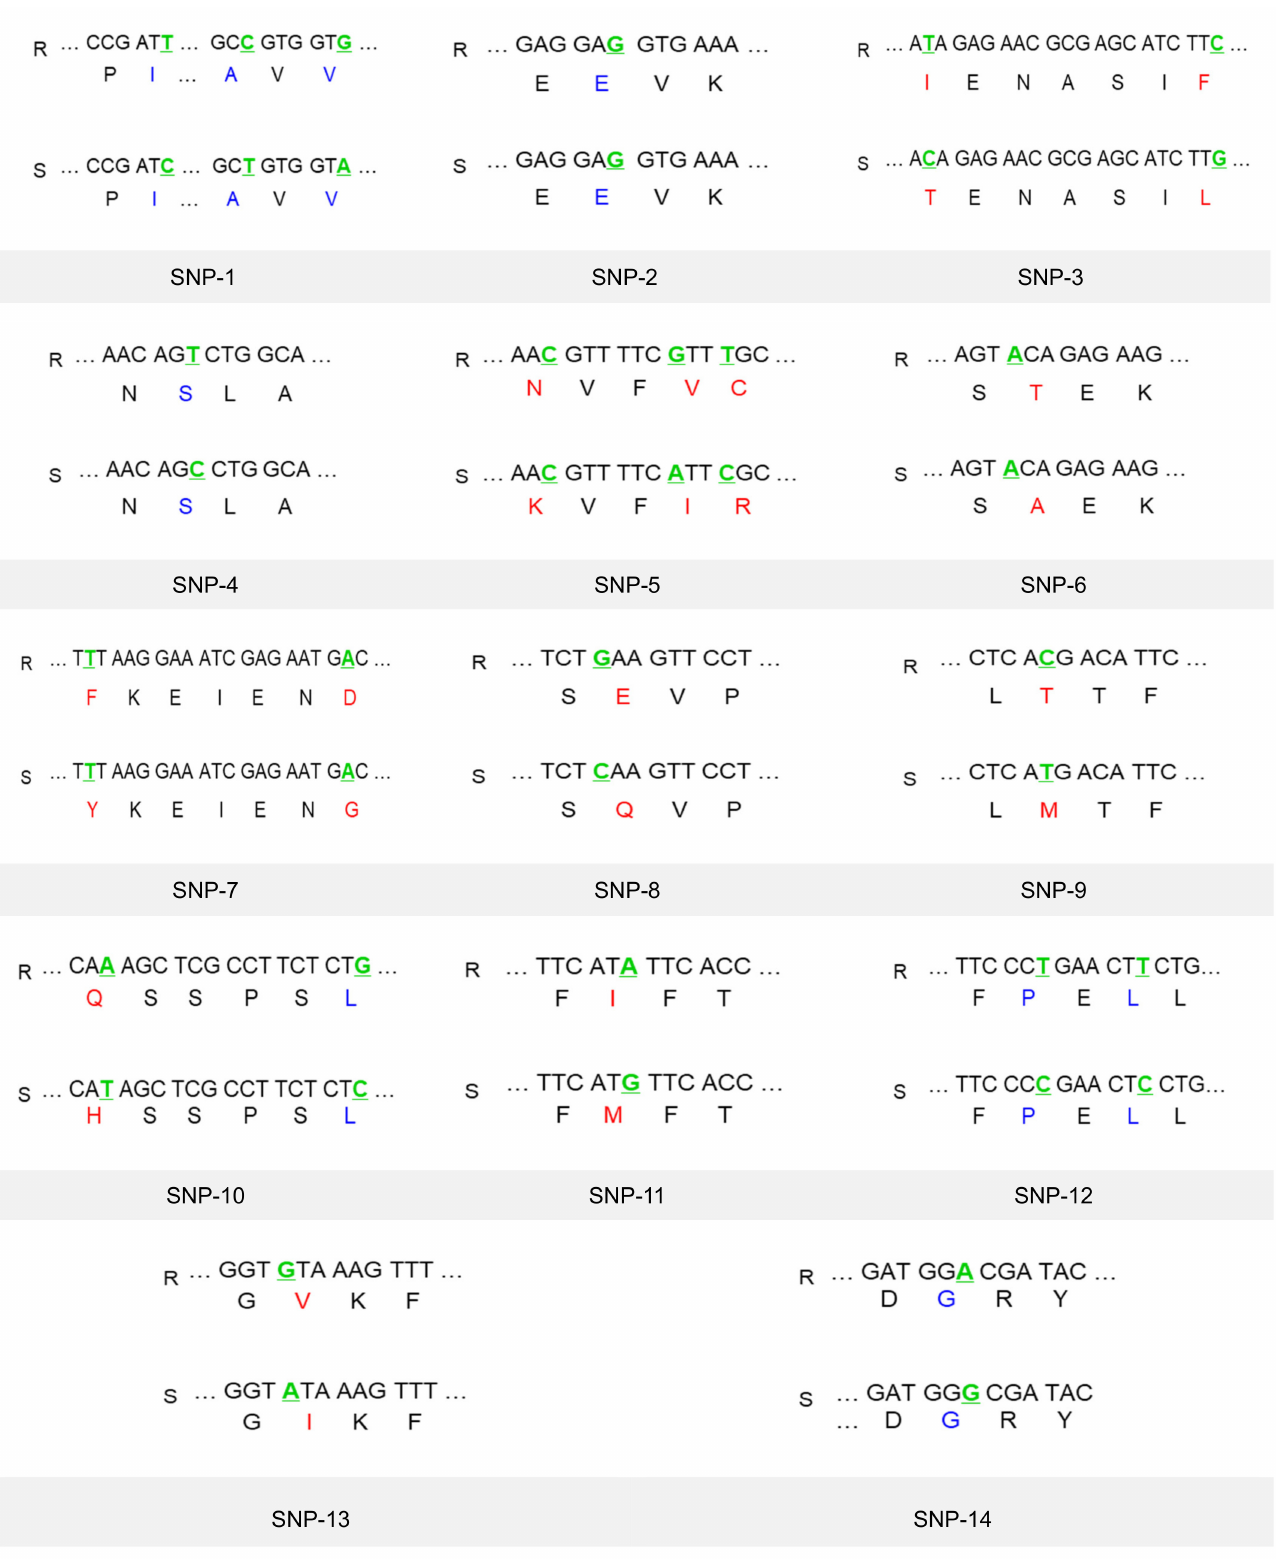
Figure 5. SNPs and amino acid sequences targeted by the HRM primers in the resistant and susceptible lines. The SNPs targeted by HRM primers are shown in green. The synonymous mutations are shown in blue, and the nonsynonymous mutations between the resistant and susceptible groups are shown in